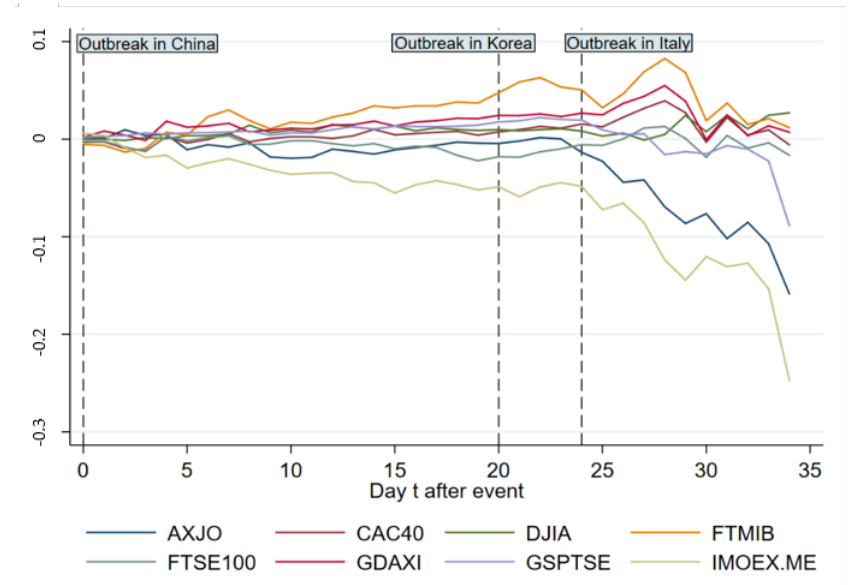
Figure 5. CAR change of main indices out of Asia from day 0 to 34.